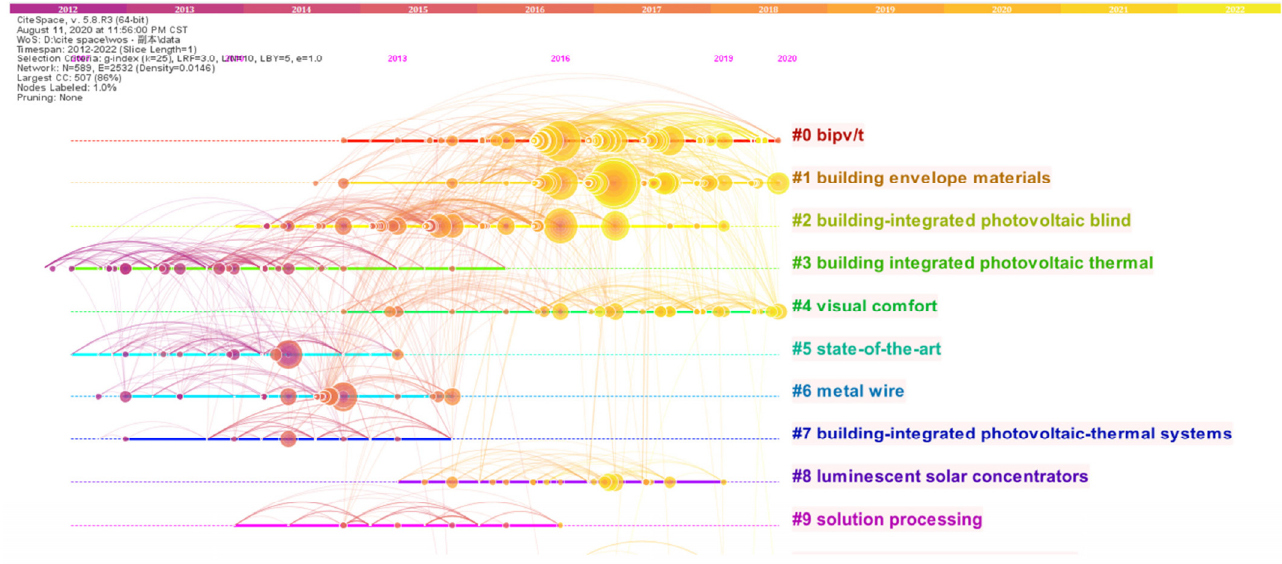
Figure 7. Literature co ‐ citation timeline.